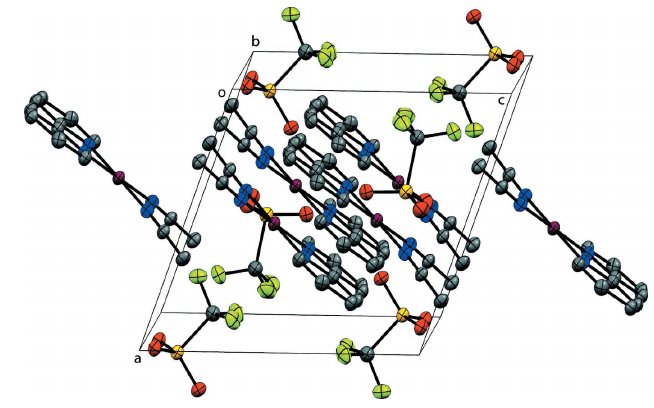
Figure 1 The molecular structure of the title compound with displacement ellipsoids drawn at the 50% probability level; H atoms are omitted for clarity. Symmetry code: (i) x , (cid:4) y + 3